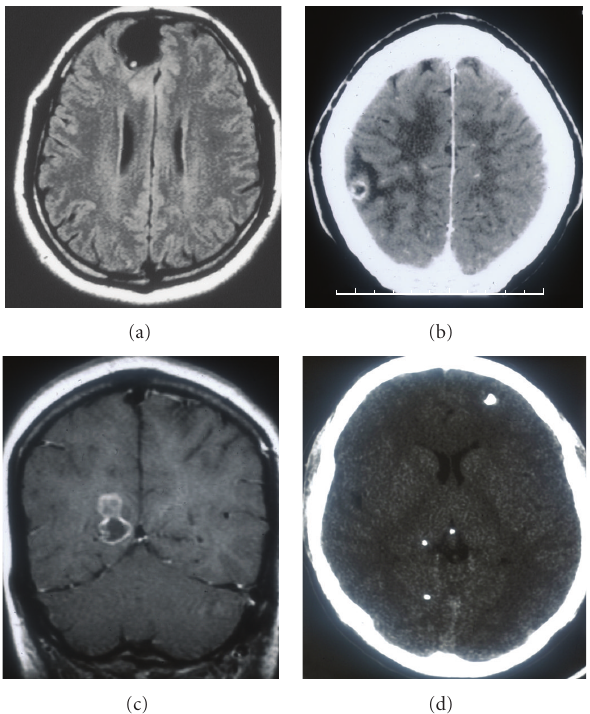
Figure 2: (a) MRI image revealing vesicular cysticerci (the central dot represents the scolex). (b) Cyst beginning to degenerate with perilesional edema and enhancement in the colloidal stage. (c) Cyst in the granular stage without perilesional edema. (d) CAT scan revealing multiple calcifications in the calcified